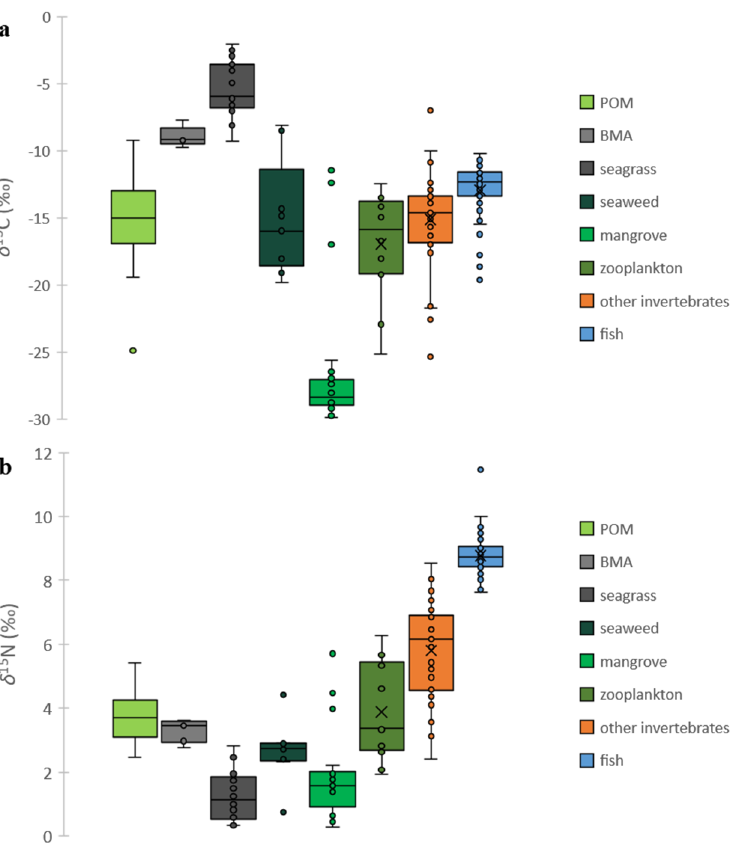
Figure 3. Box and whisker plots of ( a ) δ 13 C and ( b ) δ 15 N values showing the median, 25% and 75% quartiles, with the whiskers showing the minimum and maximum. If the mean is significantly different from the median, an X is used to mark the mean. If present, outliers are shown (circles). Across the reserve, there were similar δ 15 N values for POM, from 2.6 to 5.2‰ (Figure